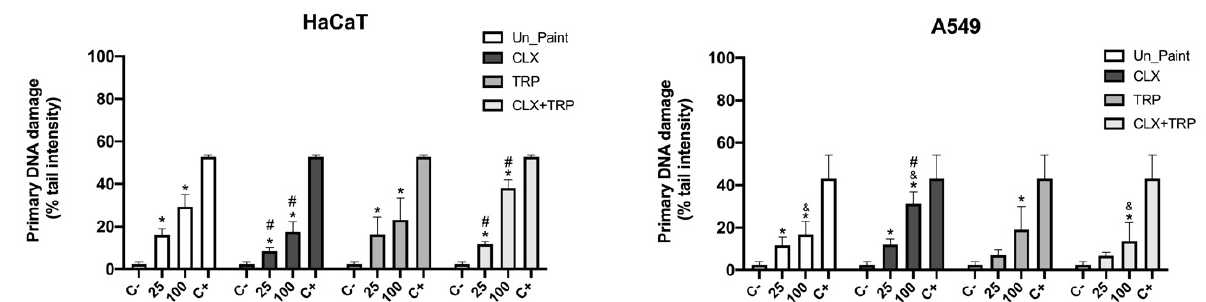
Figure 6. Results of alkaline comet assay, with HaCaT ( left ) and A549 ( right ) cell lines, after expo- sure to Un_Paint, CLX, TRP, or CLX+TRP extracts for 24 h. C − negative control (complete medium), C+ positive control (MMS 800 µ M solution). The values are expressed as mean ± standard deviation. The statistical significance of samples compared to C − is represented by * (One-way ANOVA; p < 0.05). The statistical significance of samples compared to Un_Paint is represented by # (Two-way ANOVA; p < 0.05). The statistical significance of the extract on A549 cells compared to the same extract, in the same concentration, on HaCaT cells is represented by & (Two-way ANOVA; p < 0.05). TRP presented values similar (16.25 ± 8.18%) to Un_Paint 25%; however, it presented lower values (23.17 ± 10.26%) of primary DNA damage in the original extract at 100%. On its turn, CLX+TRP revealed a decrease in single-strand DNA breaks for the 25% extract (11.80 ± 1.20%) relative to the Un_Paint; however, for the 100% extract it was the paint with higher values of primary DNA damage (38.16 ±